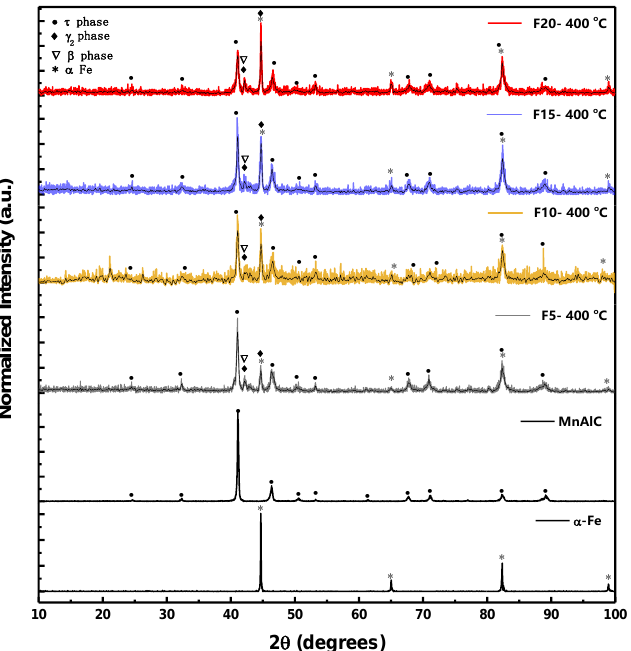
Figure 1. XRD patterns of Fe NPs, Mn-Al-C alloy, and magnetic composite samples.